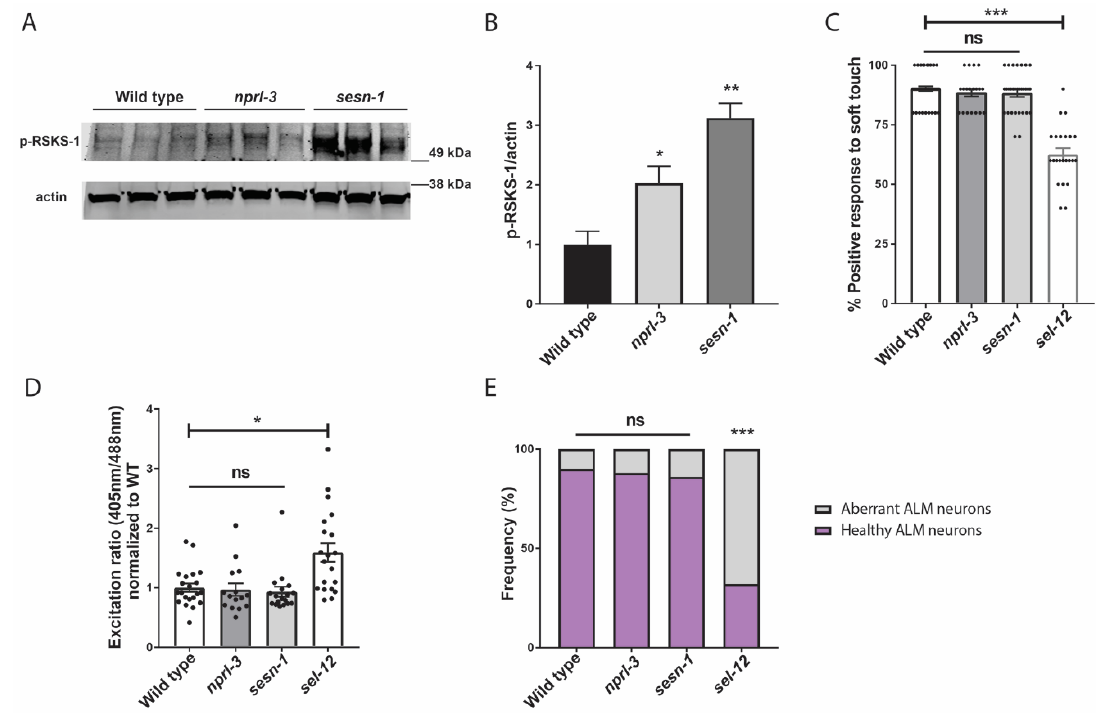
Figure 6. Hyperactivation of mTORC1 is not sufficient to cause neurodegeneration. ( A ) Western blot of p-RSKS-1/S6k in wild type, nprl-3 and sesn-1 mutants indicating increased mTORC1 activity and ( B ) quantification of p-RSKS-1/actin in ( A ). ( C ) Quantification of response to anterior and posterior soft touch in wild type, sesn-1 , nprl-3 , and sel-12 mutants. (n = 20). ( D ) Relative mitochondrial oxidation levels in animals expressing mitochondria targeted roGFP1 in the TRNs. (n ≥ 15). ( E ) Quantification of frequency of healthy and aberrant ALM neurons present in wild type, sesn-1 , nprl-3 , and sel-12 mutants. (n ≥ 20). ns p > 0.05, * p < 0.05, ** p < 0.01, *** p < 0.001 using one-way ANOVA with Kruskal-Wallis multiple comparison test. Comparisons are made to wild type unless otherwise indicated. Error bars indicate mean +/ − SEM.